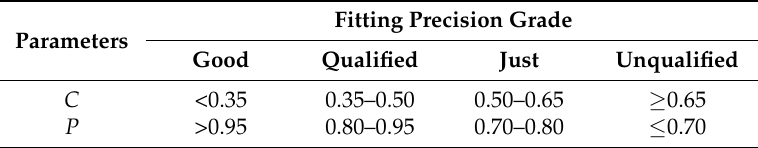
Table 1. Reference for the fitting precision